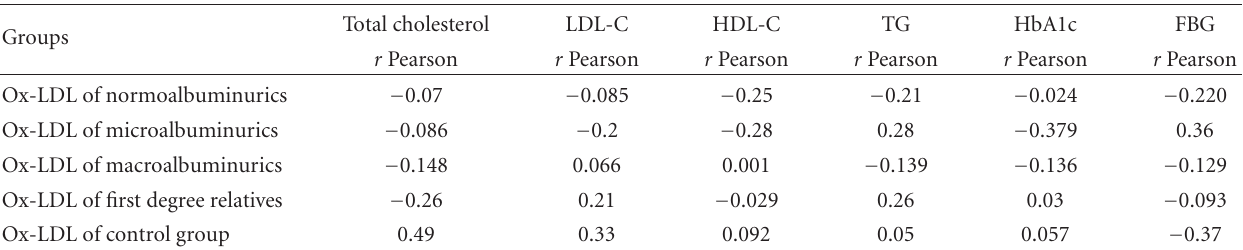
Table 4: Spearman’s correlation coe ffi cients between lipid parameters, FBG, HbA1c, and OX-LDL in all groups of the study.